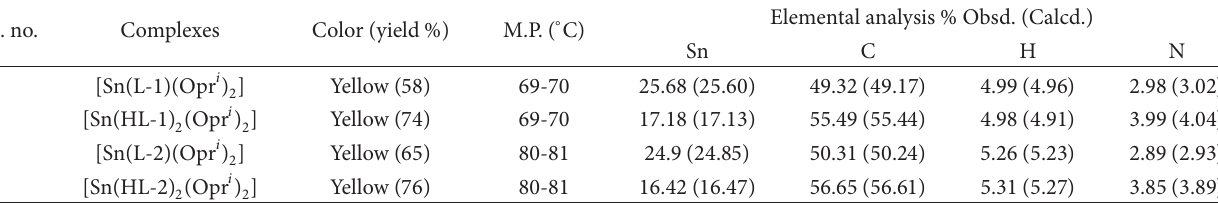
T 1: Elemental analysis of complexes.